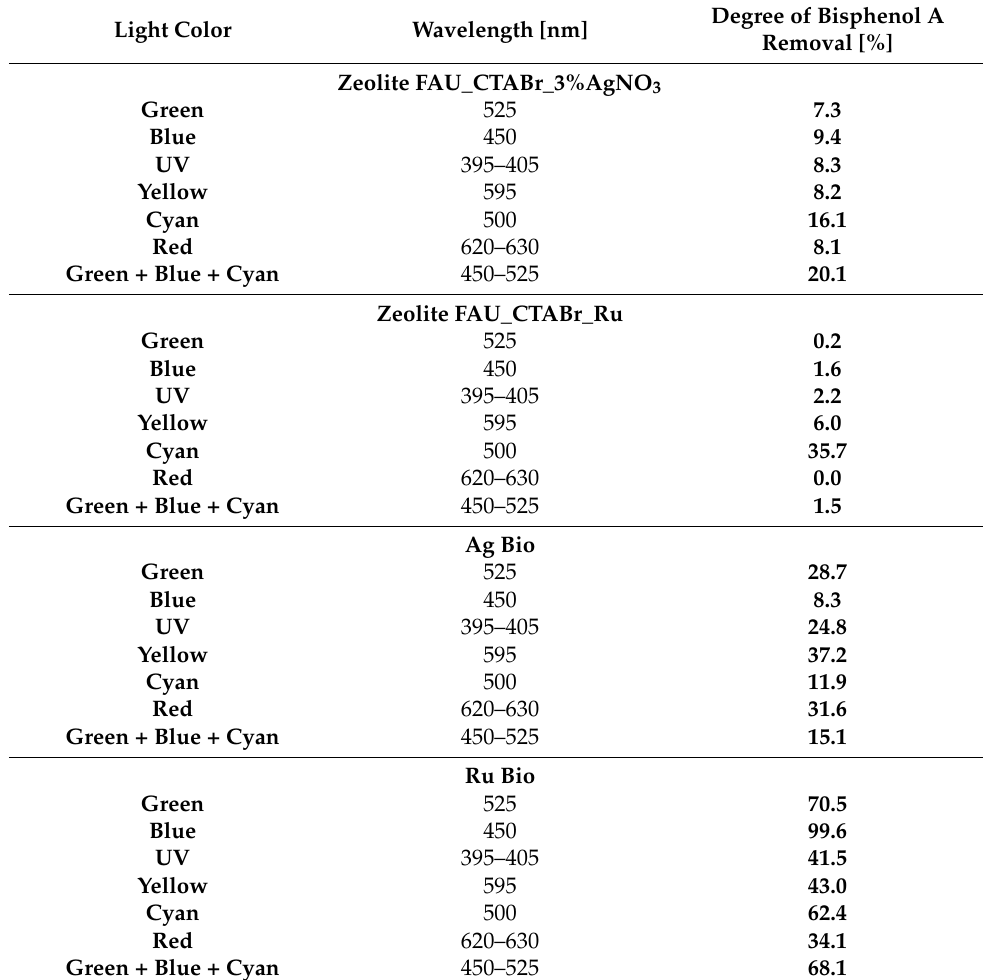
Table 2. Summary of the results obtained in the photocatalytic removal of bisphenol A using selected catalysts (the time of light reaction—270 min, pH 7, T = 25 ◦